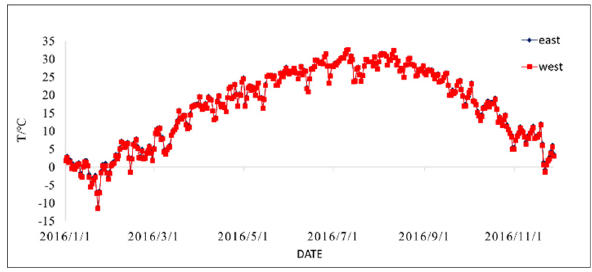
Figure 2. Temperature comparison diagram